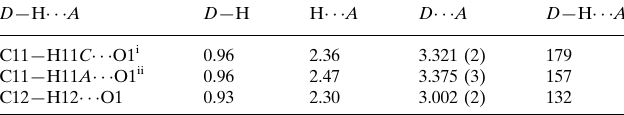
Hydrogen-bond geometry (A˚ , (cid:1)